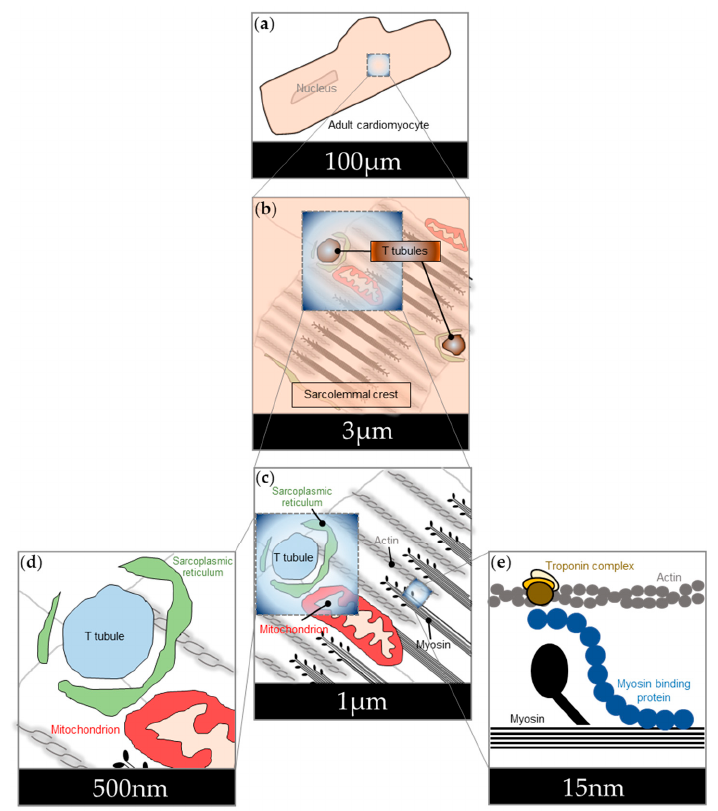
Figure 2. Scales of cAMP signalling domains in adult cardiomyocytes. Continued development of cAMP detection methods improved the resolution of cAMP signal measurement within adult cardiomyocytes. ( a ) Initially, whole-cell and fractionation assays across a 100 μ m long adult